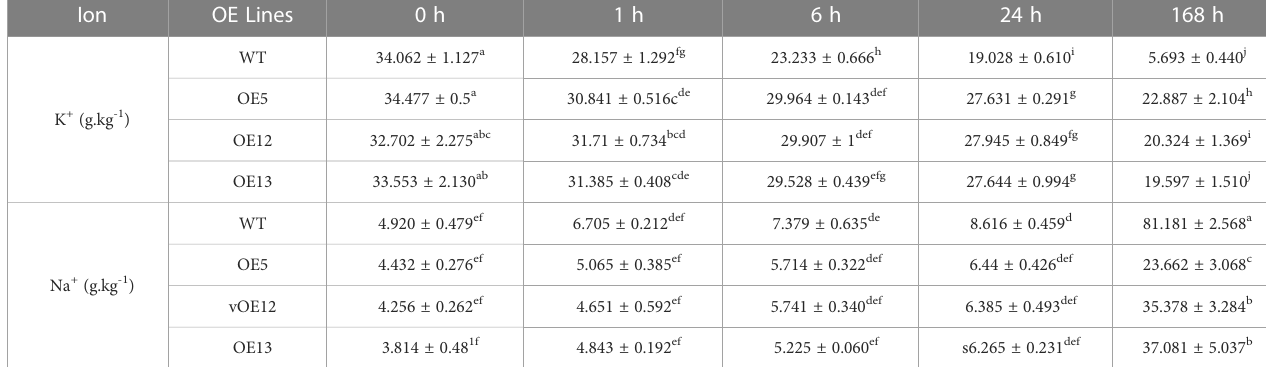
The different letters represent signi fi cant differences among the treatments on each date (one-way analysis of variance (ANOVA) followed by using Duncan's Multiple Range Test,